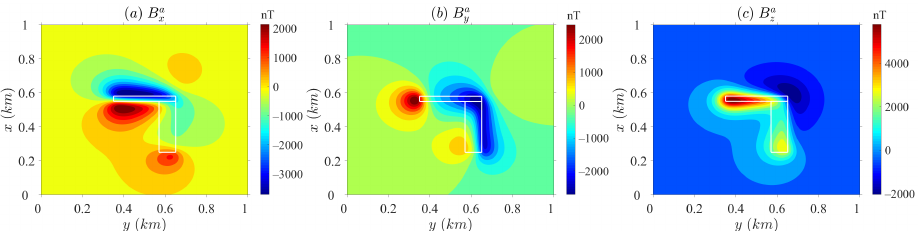
Figure 12. Surface anomalous magnetic fields due to the two-dike model with susceptibility of 3 SI.